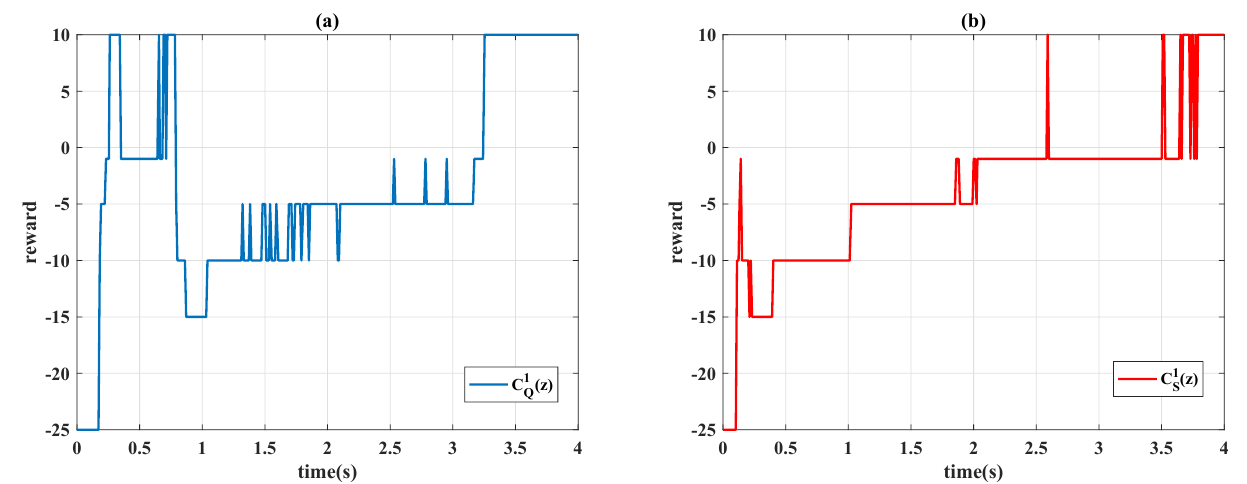
( z ) ; ( b ) Sarsa C 1 ( z ) . Q S